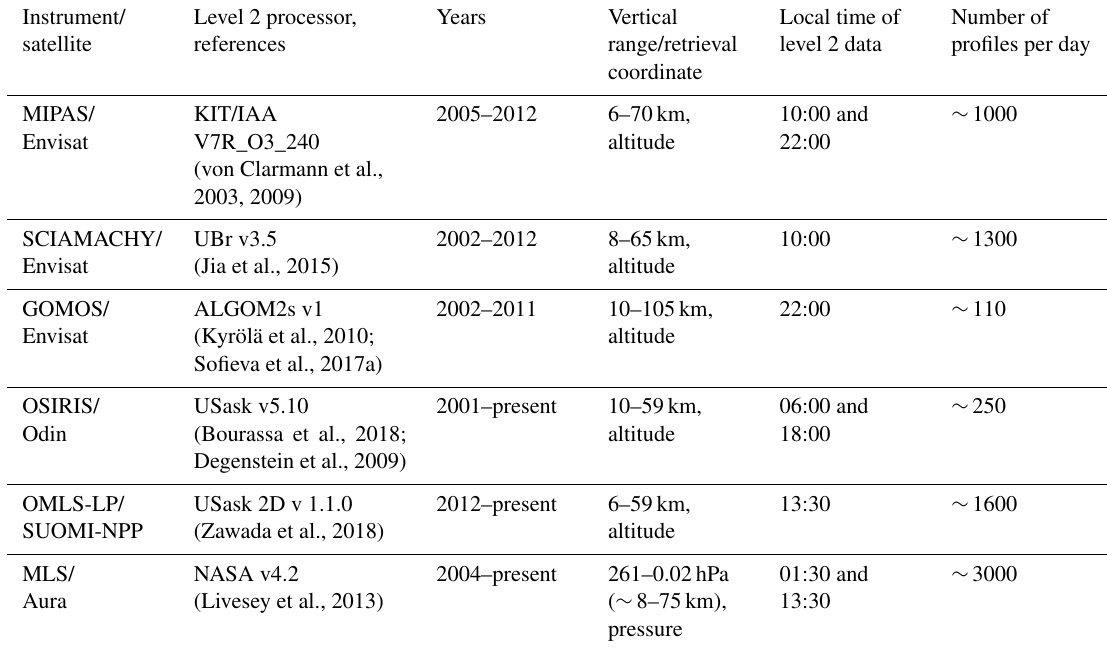
Table 1. General information about the